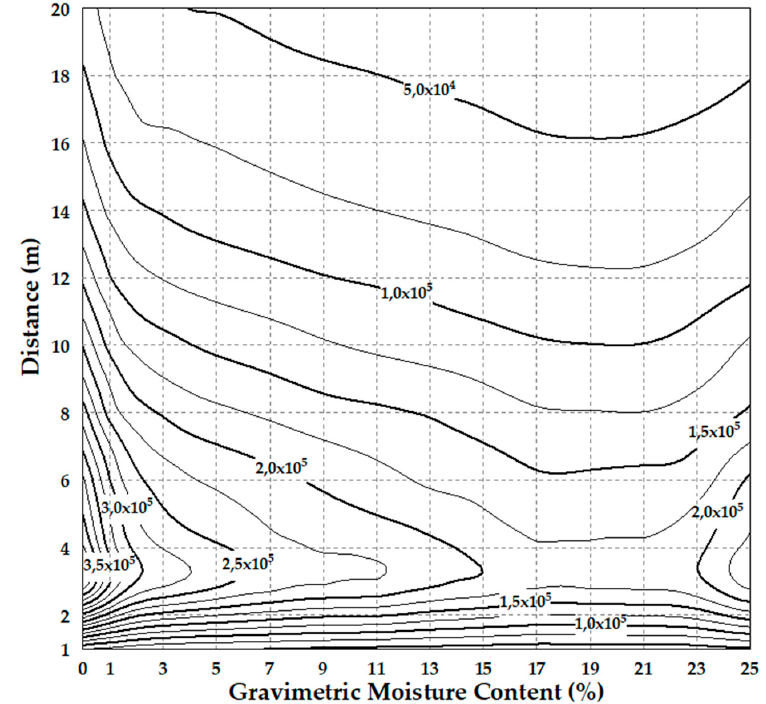
Figure 5. Contour lines of the Z&F / Leica HDS6100 original intensity versus the distance (1–20 m) and the gravimetric moisture contents (0–25%) when scanning sand samples orthogonally.